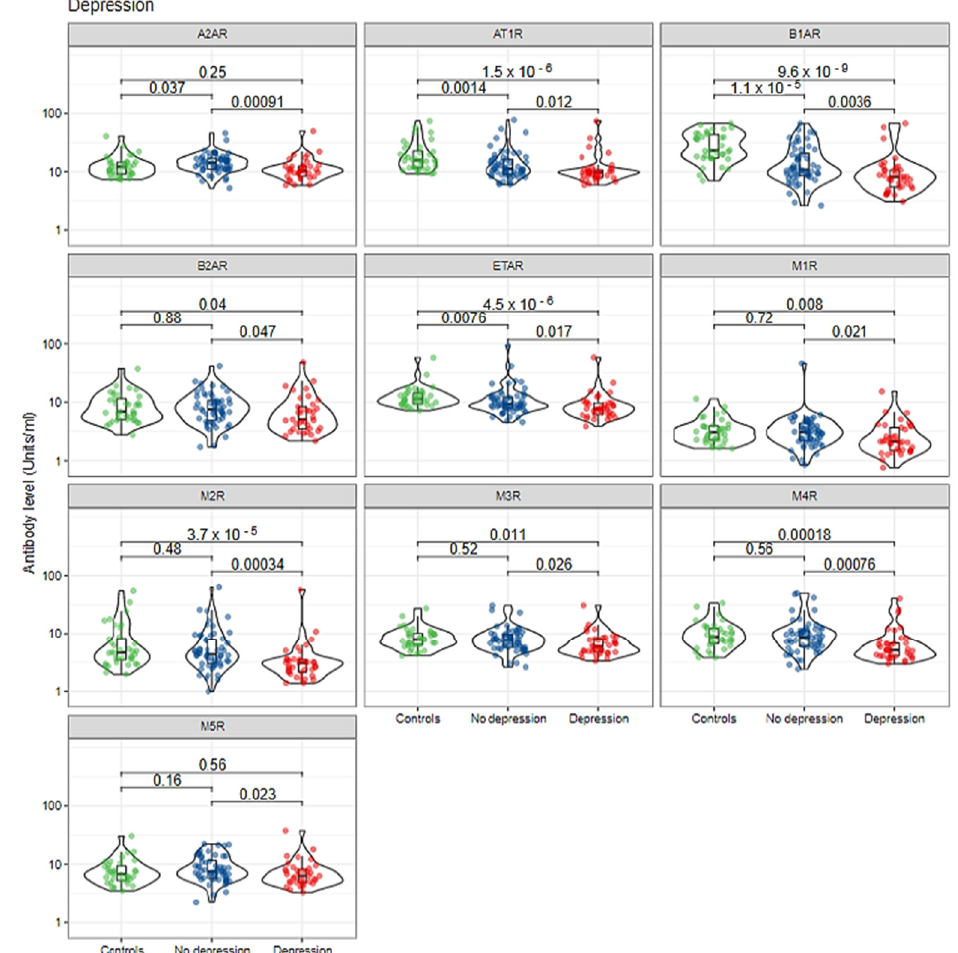
Figure 4. Autoantibodies against autonomic nervous system receptors are correlated with depression in symptomatic women with SBIs. Individual measurements are shown as dots, summary data as box plots, and the distributions as violin plots. Green dots: healthy controls; blue dots: silicone-breast-implant patients without clinical manifestations; red dots: silicone-breast-implant patients with clinical manifestations.